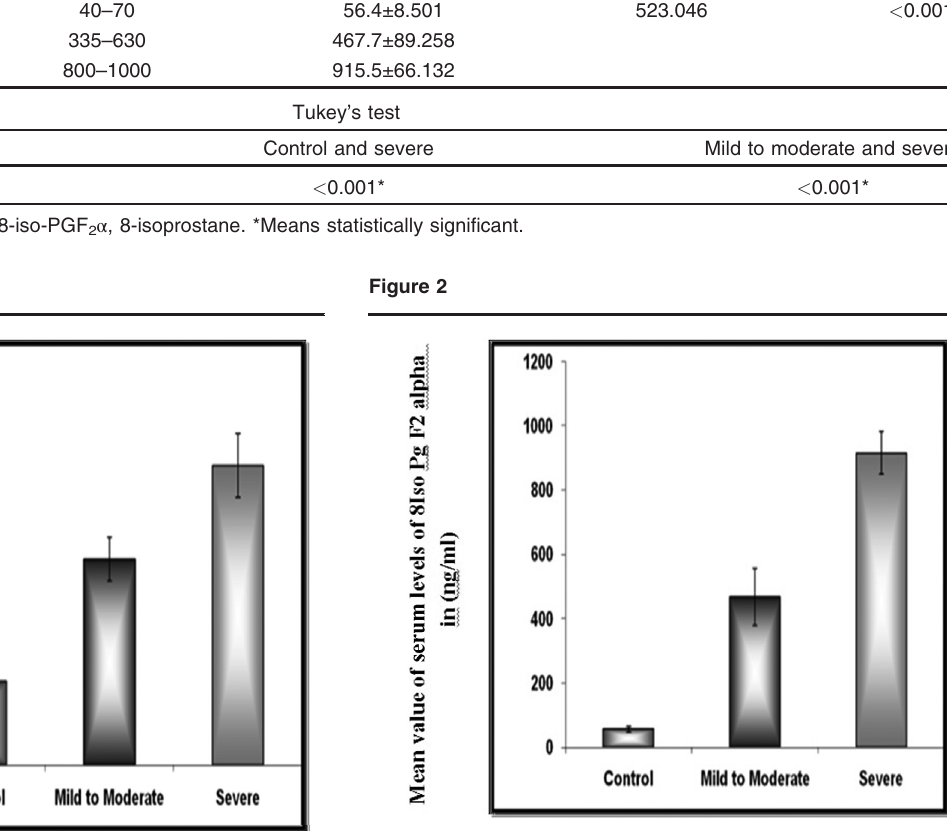
Statistical comparison of range, mean±SD value of bronchoalveolar lavage fluid levels of 8-isoprostane (ng/ml) in the three studied groups.